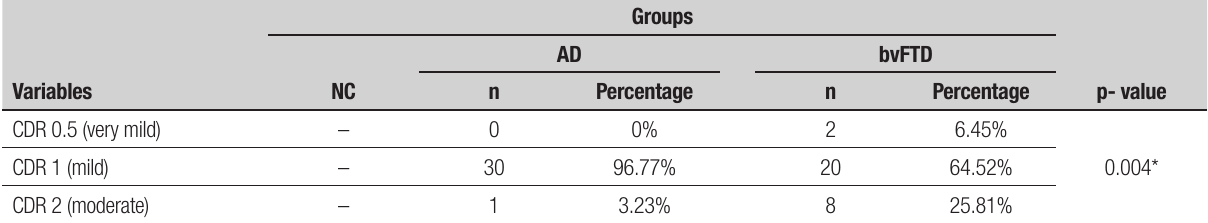
Table 3. Disease severity of the clinical groups.